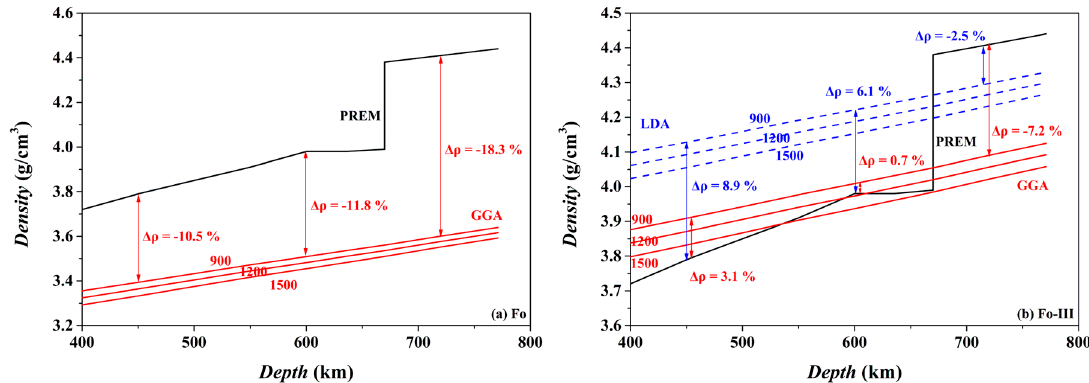
Figure 17. Calculated isothermal density-depth profiles at 900, 1200 and 1500 K for Fo ( a ); and Fo-III ( b ). As a reference, the PREM density model [98] is also sketched. The shown density difference ( ∆ ρ ) at 450 km depth, 600 km or 720 km depth and 900 K is calculated as ∆ ρ = 100 × ( ρ -Fo − ρ -PREM )/ ρ -PREM , where ρ -Fo stands for ρ -Fo in ( a ), and ρ -Fo-III in ( b ). The GGA results at different T are shown as red lines while the LDA results as blue lines. For the purpose of illustration, the density differences at certain depth obtained by the GGA method and the LDA method are slightly horizontally shifted.